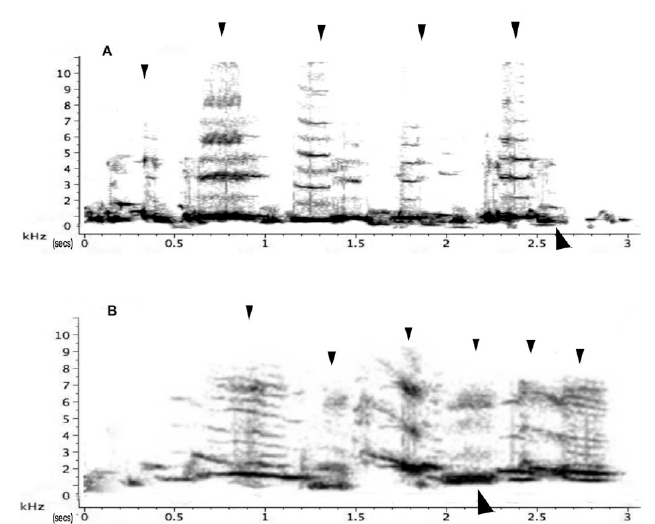
Figure 4. Two examples of a carolling bouts (from birds from different territories). Y-axis: frequency in kHz; X-axis: time in secs. Black arrows facing downwards indicate a single sound; arrows from below identify the first formant (dark area). Formants are frequency peaks in the spectrum which have a high degree of energy. In the first sample ( A ) harmonics are well defined, giving the carolling a tonal quality. In ( B ), however, the sonogram is fuzzy and grey, indicating that the sounds produced are noisy and harsh. In most songbirds, upper harmonics (parallel lines above first formant) usually have little energy. In carolling, however, there is still substantial energy (i.e., are audible at 6 kHz ( A ) and even 7 kHz ( B )). The darkness of the trace is proportional to the energy (or amplitude) of the signal. Sound amplitude is experienced as the loudness of sound. The ability of magpies to vary sound intensity depends on vocal tract manipulation and even on its length [30].